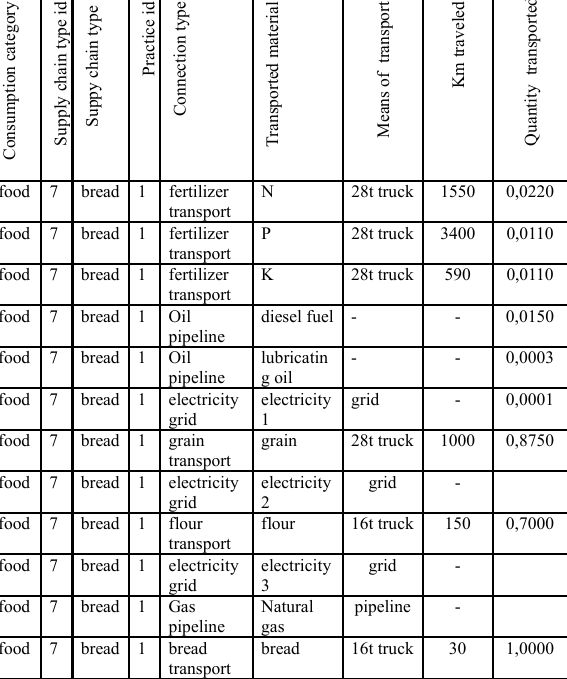
Table 2. Some of the data associated with the IG connections of a bread supply chain, average italian practice (data refer to 1kg of bread) 2.4 Reference functional